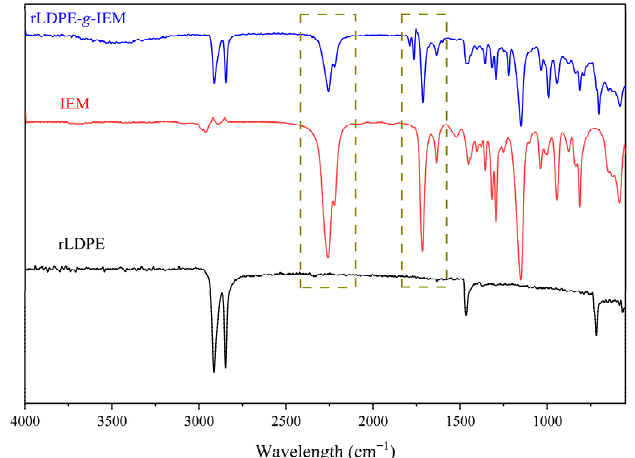
Figure 3. FTIR spectra of rLDPE, IEM, and rLDPE- g -IEM.